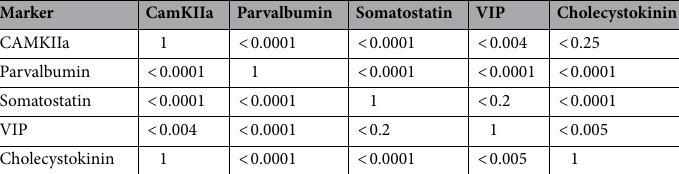
Table 3. Statistical significance between fractions of antibody labeled neurons (p values).